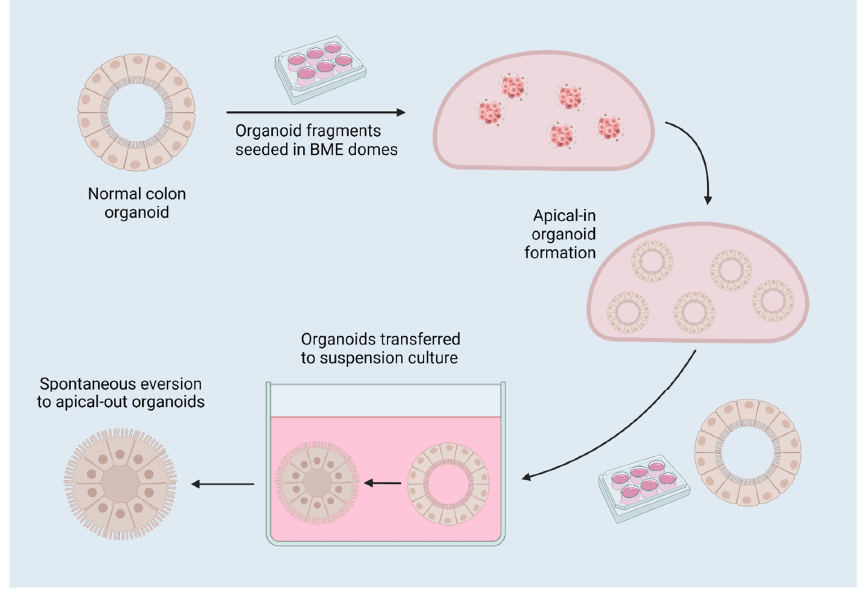
Figure 3. A diagram of reverse-polarity colon organoids. Organoids are established in 3D matrix domes, then released for culture in suspension, which induces spontaneous eversion to apical-out organoids due to the removal of interactions with surrounding matrix. Created with BioRender.com 17/07/2022.